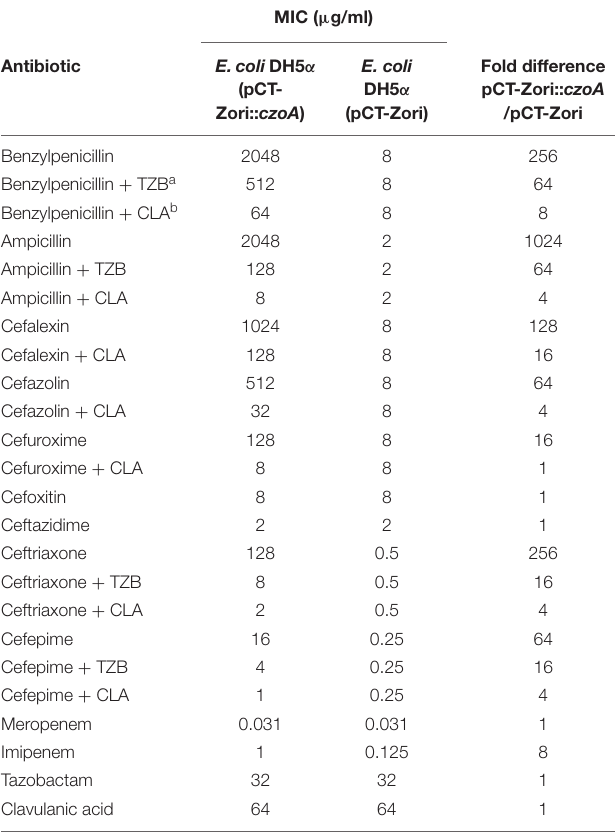
TABLE 1 | β -Lactam activity against E. coli DH5 α expressing